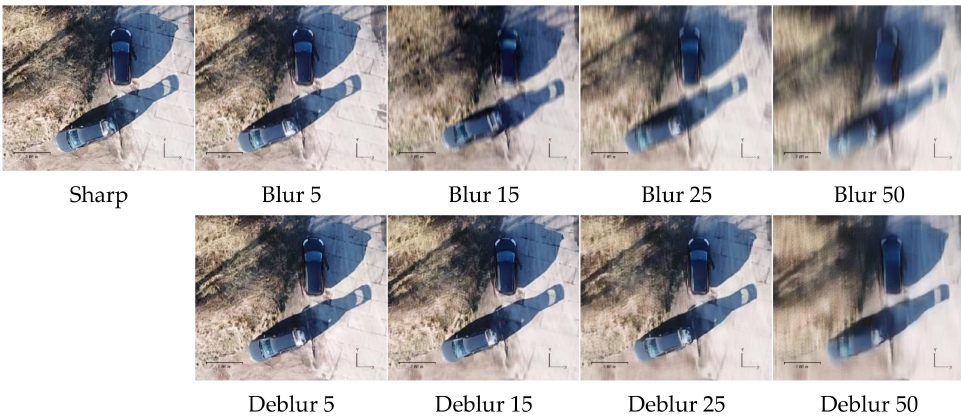
Figure 10. Orthoimage—visual comparison of a product part developed using photos with a varying blur kernel and their corresponding product, after the application of the method.